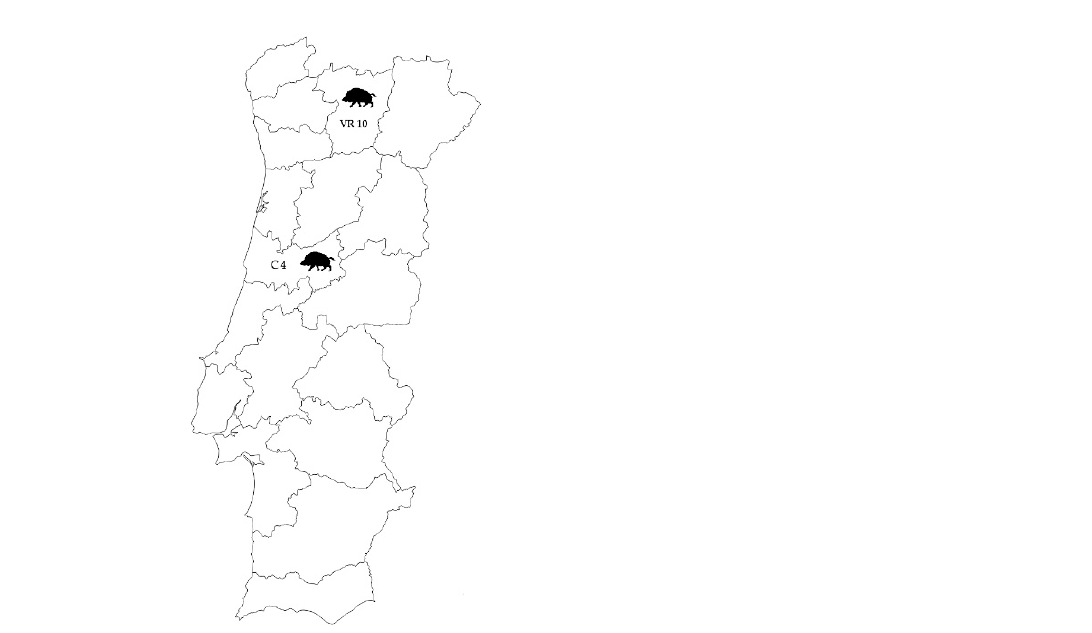
Table 1. Primer sequences used for detection of H. pylori and H. suis and thermo cycling conditions. Primer Sequence Region Amplicon Size Primer ureAB gene